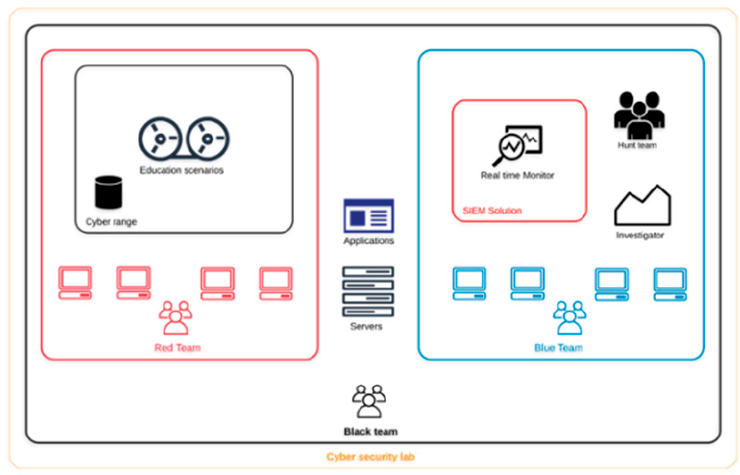
Figure 3. The main components of Q8CR architecture implementation.